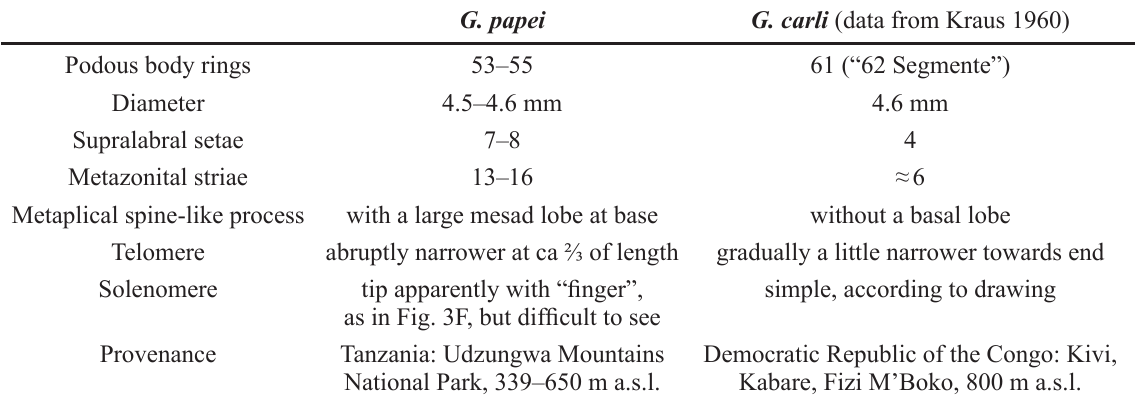
Table 1. Comparison of Geotypodon papei sp. nov. with G. carli (Kraus,